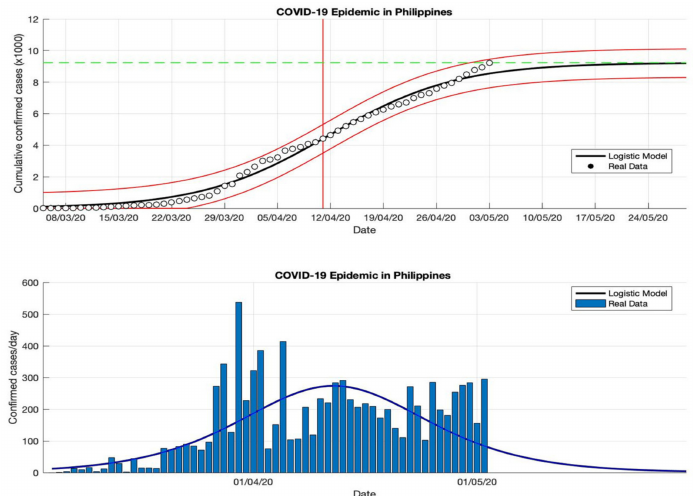
Figure 12. In the above figure, the prediction results of the logistic growth model for cumulative infected cases are compared with the actual data, while the two red lines between the black lines represent a prediction error limit of about 5%. The dashed green line predicts the total size of infected cases in the final phase of the epidemic. The red line intersects the cumulative case curve to predict the turning point or peak point of the epidemic (this line is parallel to the top of the curve from the below figure). In the below figure, the prediction results of this model for daily infected cases in the